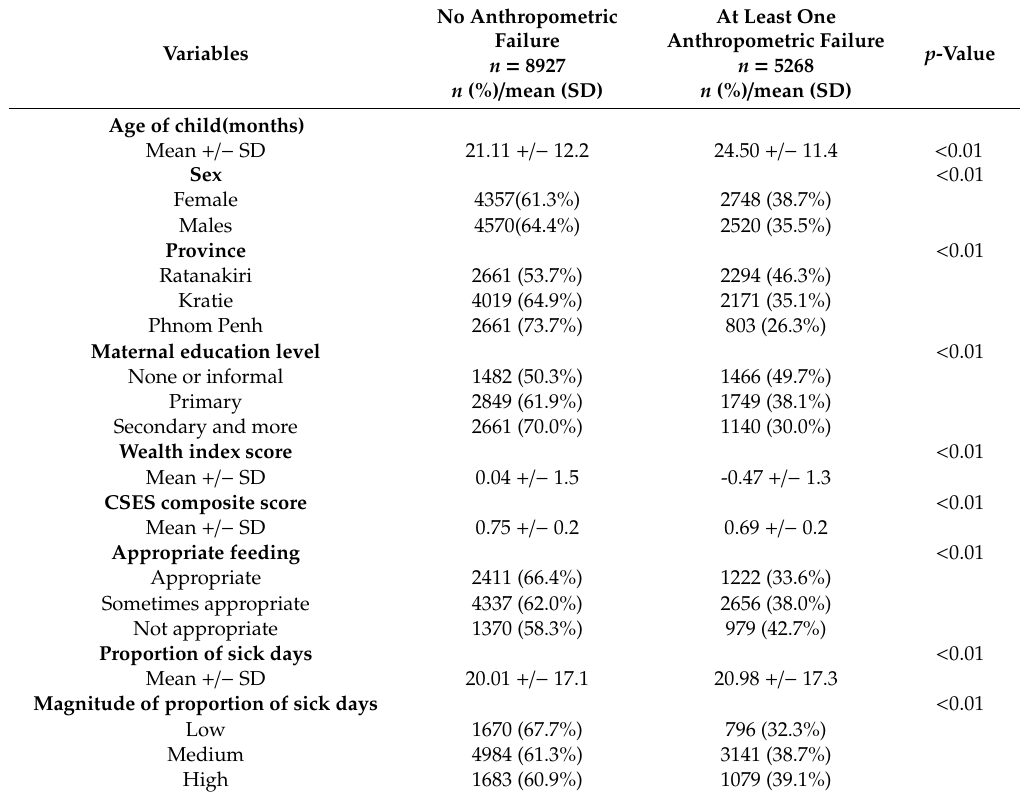
Table 2. Distribution of all observations by the absence or presence of anthropometric failure(s).